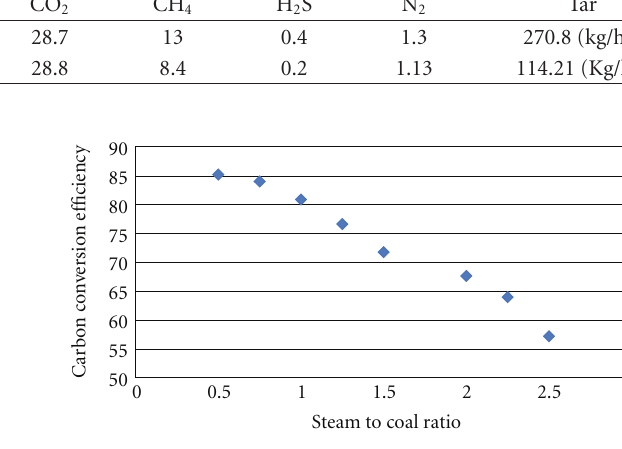
Figure 7: Carbon conversion e ffi ciency (%) versus steam to coal ratio.